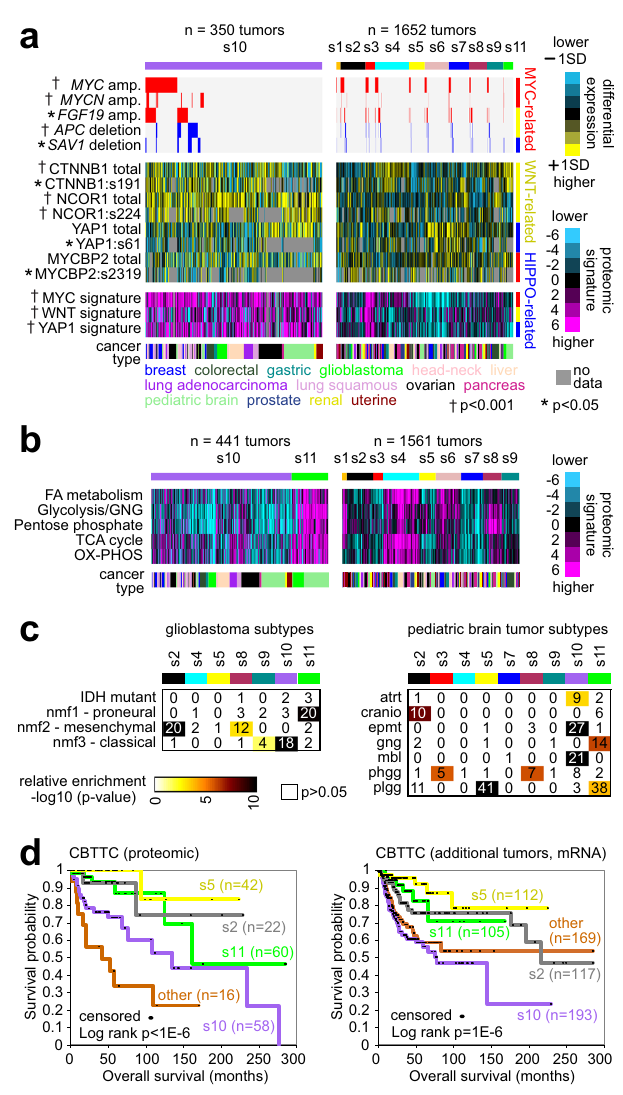
Fig. 5 Pan-cancer proteomic subtypes involving brain tumors. a Across s10 tumors, as compared to other subtypes, selected molecular features involving MYC, Wnt/beta-catenin, and Hippo pathways. Enrichment p values by one-sided Fisher ’ s exact test for ampli fi cation ( “ amp. ” ) and deletion features. p values for higher expression of protein, phospho- protein, and proteomic signatures by t -test. SD standard deviation from the median. b Across s10 and s11 tumors, as compared to other subtypes, selected proteomic signatures involving metabolic pathways. c For the proteomic-based pan-cancer subtypes involving glioblastomas (left panel) and pediatric brain tumors (right panel), the respective signi fi cances of overlap with previously identi fi ed glioblastoma subtypes 7 and with pediatric brain tumor histologic types (atrt atypical teratoid rhabdoid tumor, cranio craniopharyngioma, epmt ependymoma, gng ganglioglioma, mbl medulloblastoma, phgg high-grade glioma/ astrocytoma, plgg low-grade glioma/astrocytoma). p values by one-sided Fisher ’ s exact test. d In the CBTTC pediatric brain tumor datasets, differences in patient overall survival among the pediatric brain- associated proteomic-based subtypes. Left panel represents tumors in CBTTC with proteomic data. Right panel represents the remaining CBTTC tumors with RNA-seq data but not proteomic data, whereby RNA-seq pro fi les were assigned a proteomic subtype. p values by log- rank test. For the RNA-seq results, differences remain signi fi cant ( p = 0.002) after correcting for histologic type (by strati fi ed log- rank